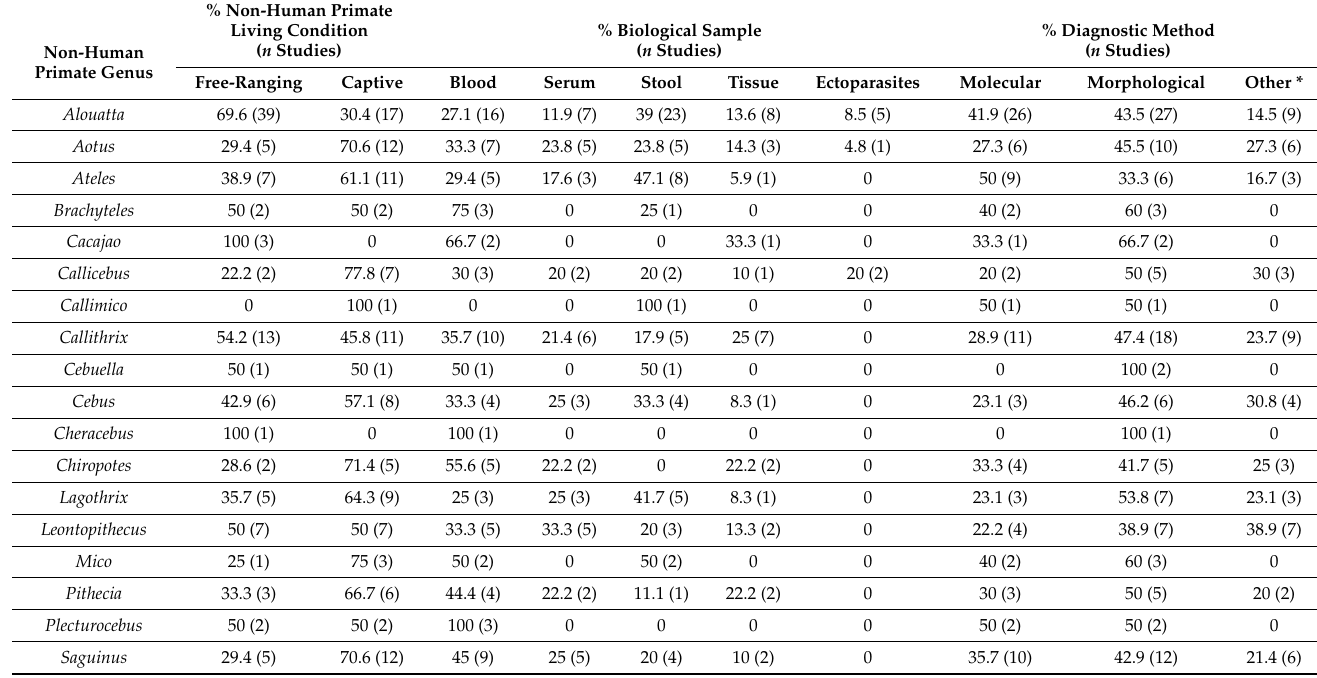
Table 2. Number of studies according to non-human primate living condition (captive/free-ranging), type of biological sample collected, and diagnostic method, per non-human primate